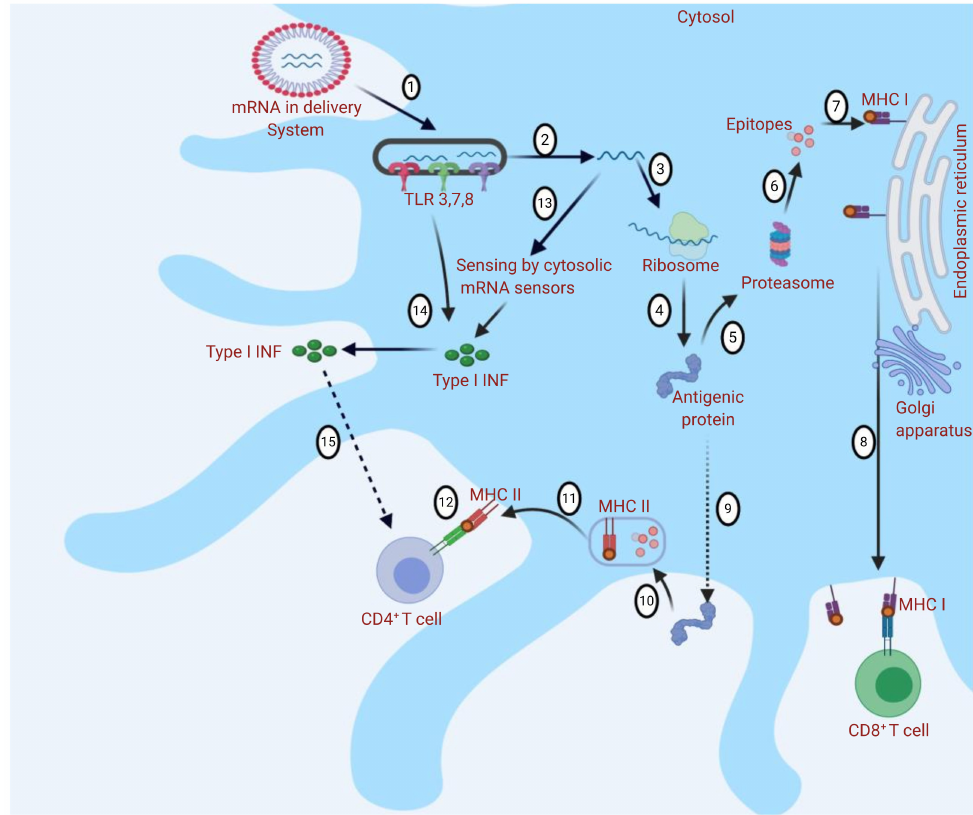
Figure 2. Different immune responses to messenger RNA (mRNA)-based vaccine nanodelivery systems: The mRNA delivery system is engulfed into the cell by endocytosis, and Toll-like receptors (TLRs) are activated (1). mRNA is released into the cytosol (2). mRNA binds to ribosome and translation occurs (3 and 4). Antigenic protein provokes the immune response through major histocompatibility complex (MHC I or MHC II) presentation (5 and 9). (5) In MHC I presentation, peptides are produced by proteolysis (6), and CD8+ T cells are stimulated (7 and 8). In MHC II presentation (9), peptides are produced by endosomal proteolysis (10 and 11), and CD4+ T cells are stimulated (12). Cytosolic sensing of intracellular mRNA leads to activation of retinoic acid-inducible gene (RIG)-I-like receptors (RLRs) and nucleotide-binding oligomerization domain (NOD)-like receptors (NLRs). Activation of TLRs, RLRs, and NLRs induces the production of type I interferons (IFNs) (13 and 14). Type I IFNs may have a positive or negative effect on the activation of T cells (as they could determine the differentiation of antigen-primed CD8 + T cells into cytotoxic effectors but may also cause T-cell exhaustion) (15). The figure was created using